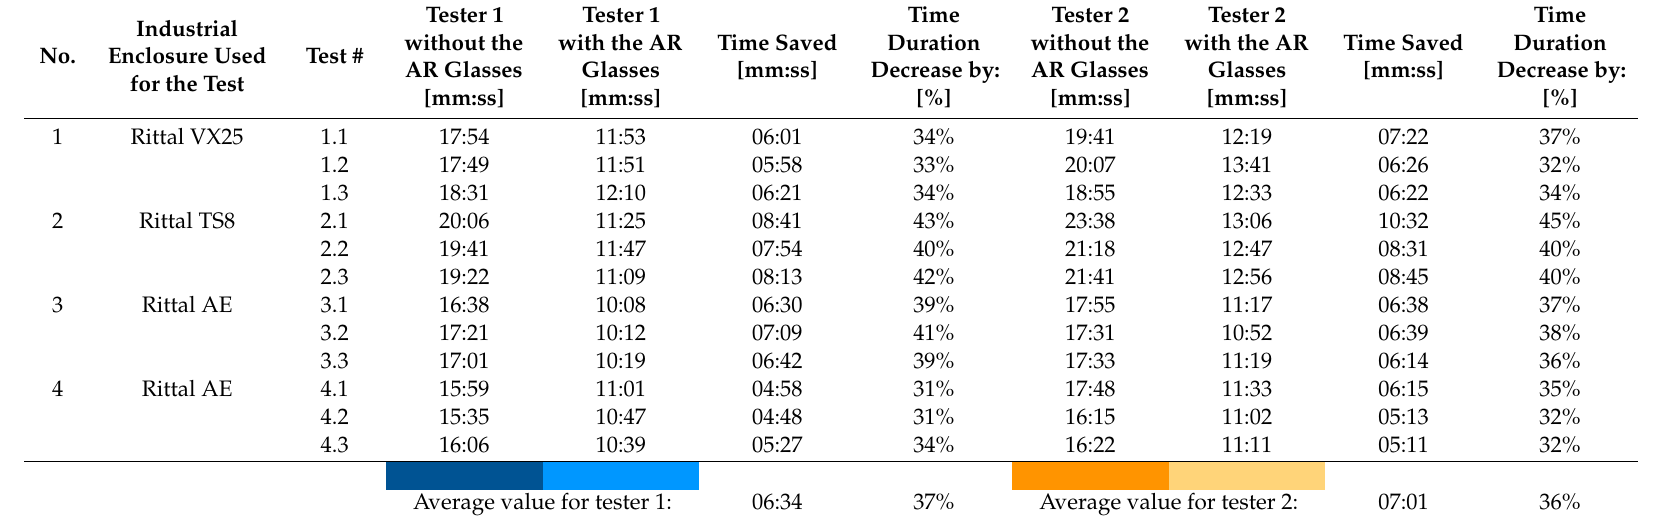
Table 2. Measured values and calculations from all 48 tests (colors given at the bottom part of this table are connected to appropriate columns’ colors given in Figure 8). Industrial No. Enclosure Used for the